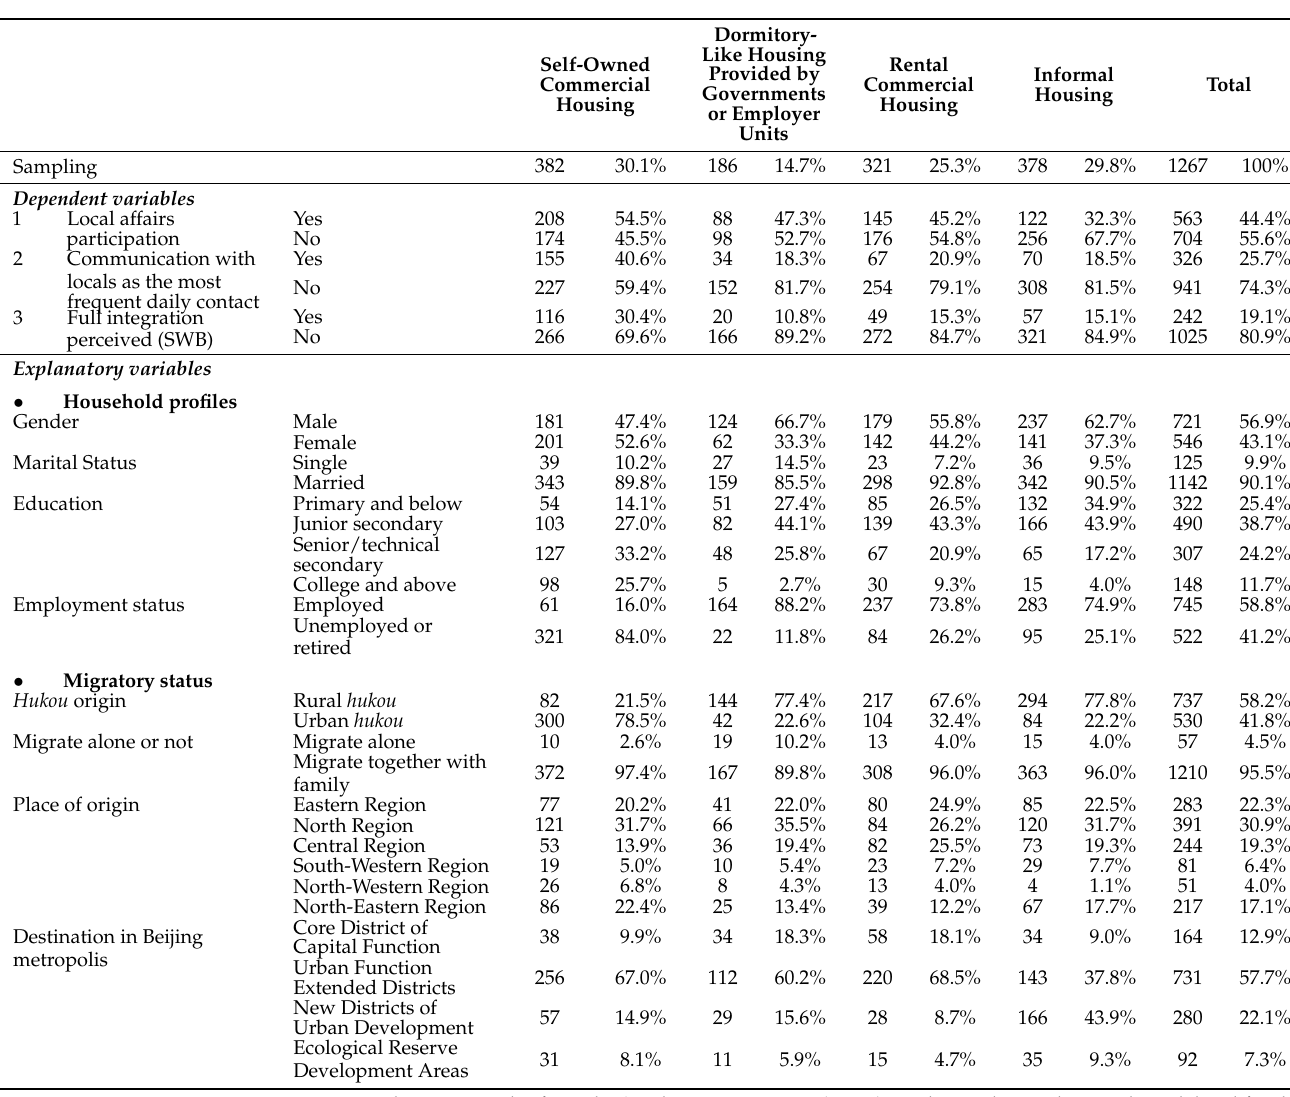
Table 2. Descriptive statistics of the aging pre-1970 migrants across the different housing tenure types in